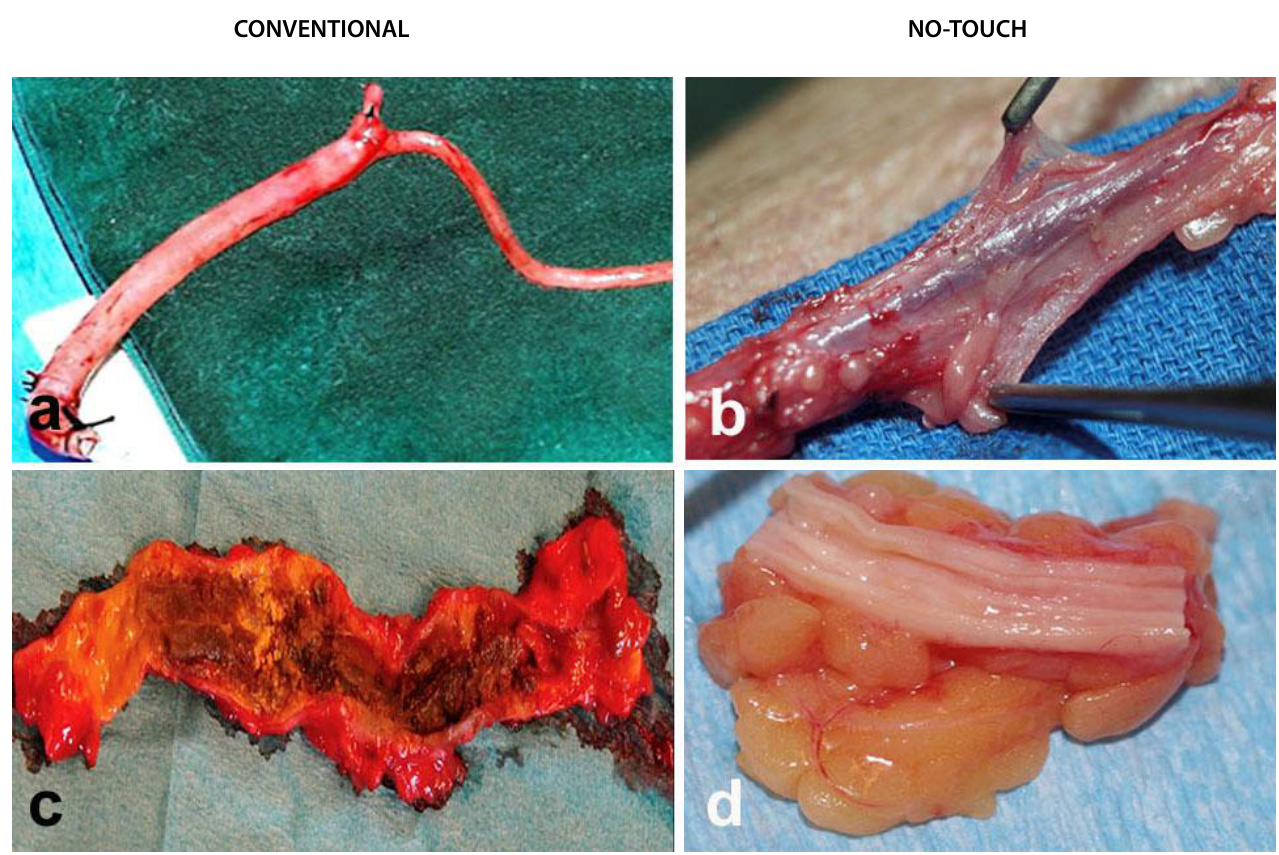
Fig. 2 – Saphenous vein grafts (SVG) at harvesting and